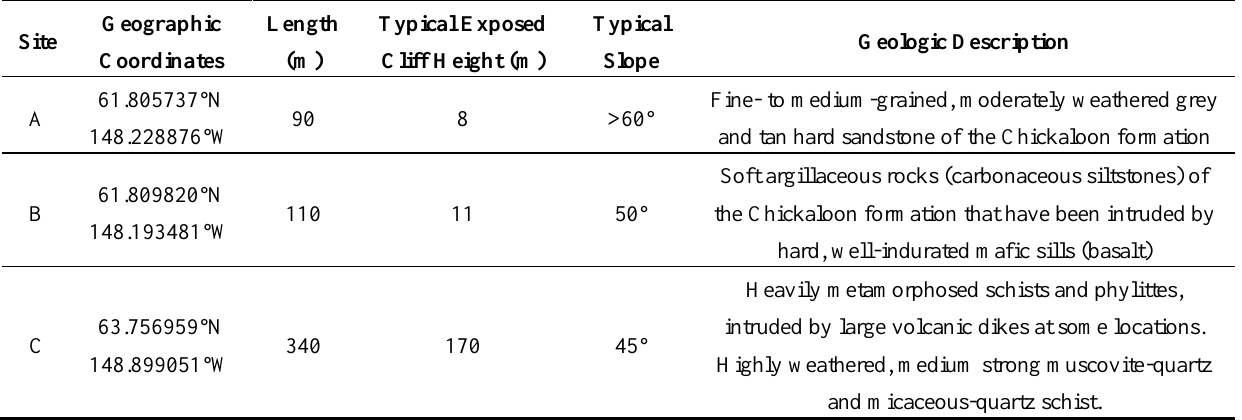
Table 2. Summary characteristics for each